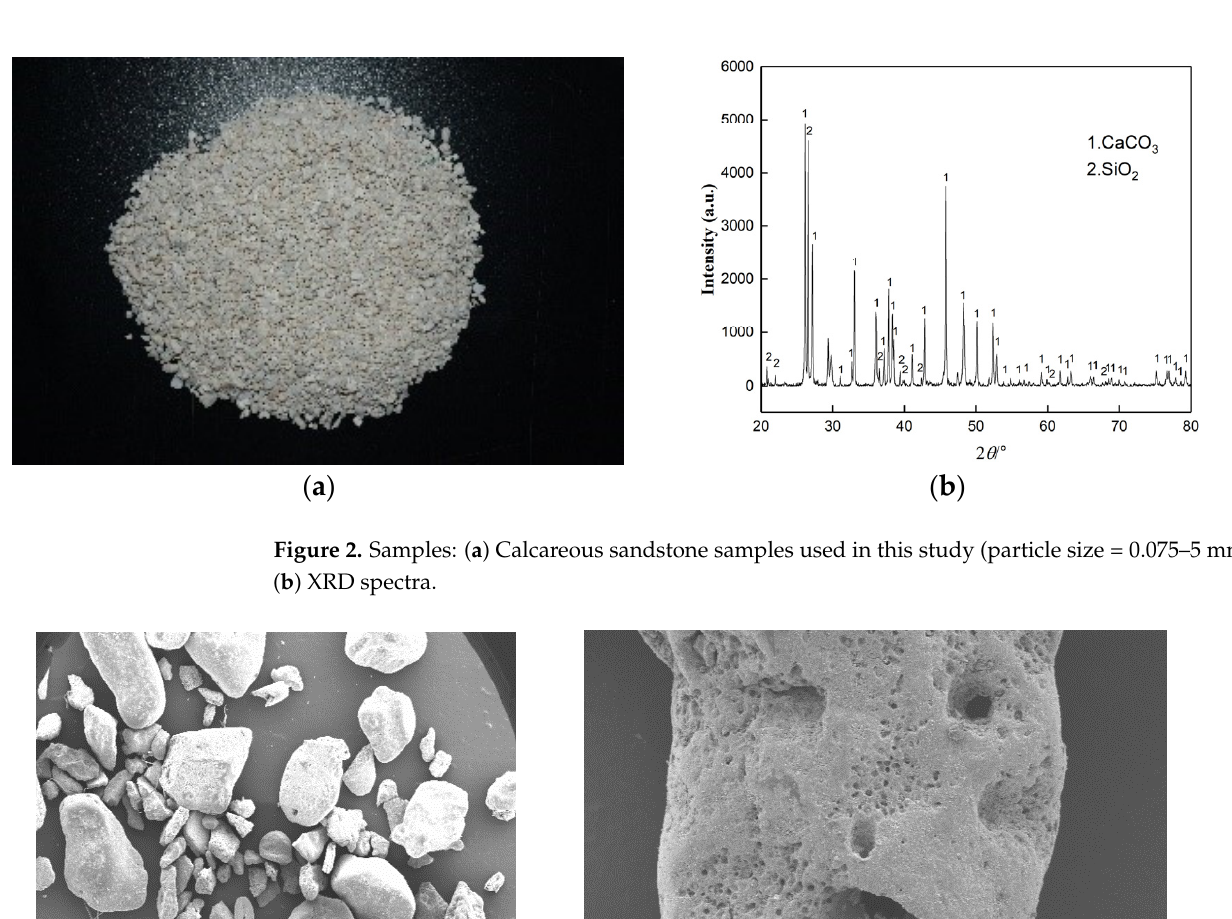
Figure 3. SEM images for the tested calcareous sand: ( a ) amplification factor of 30; ( b ) amplification factor of 50.